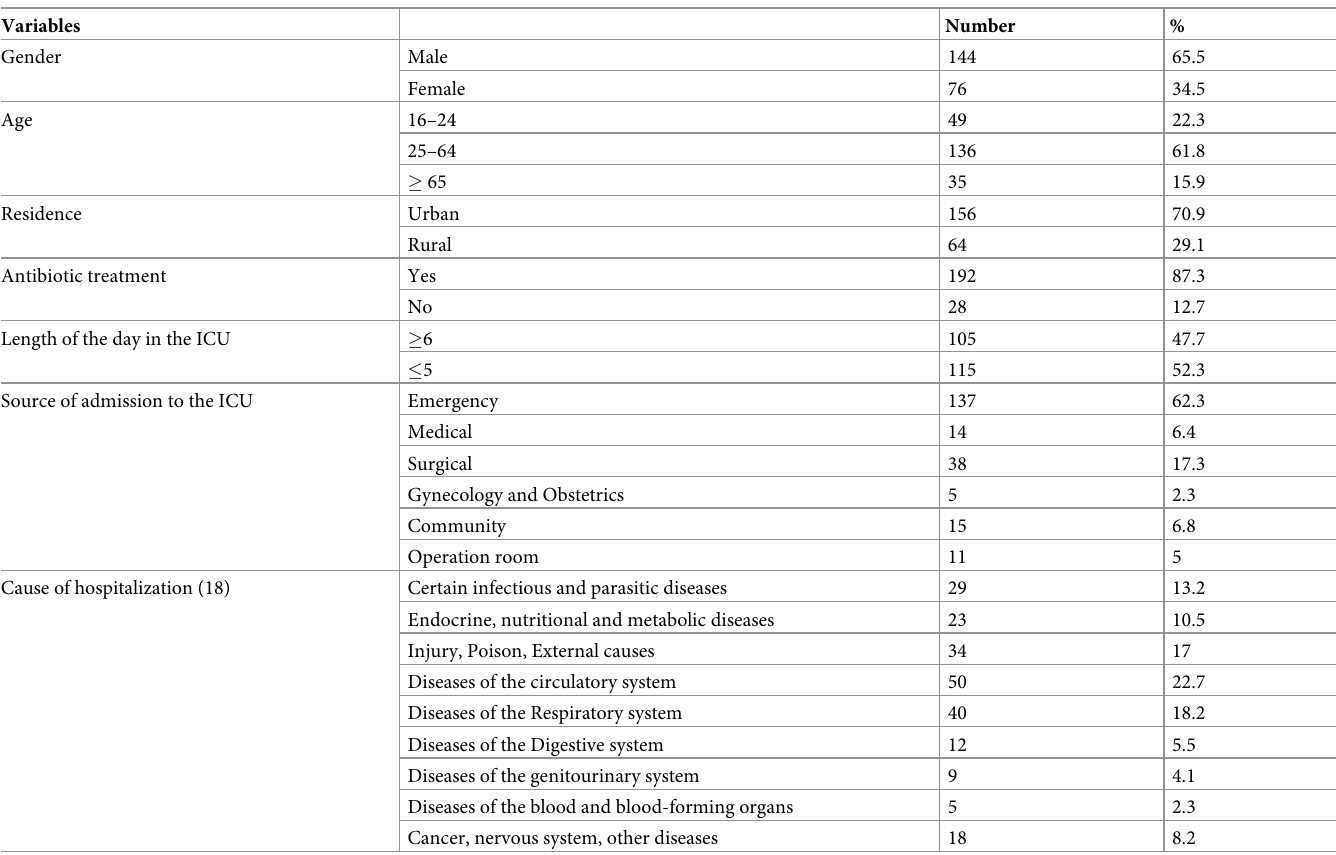
Table 1. Patients demographic data and clinical